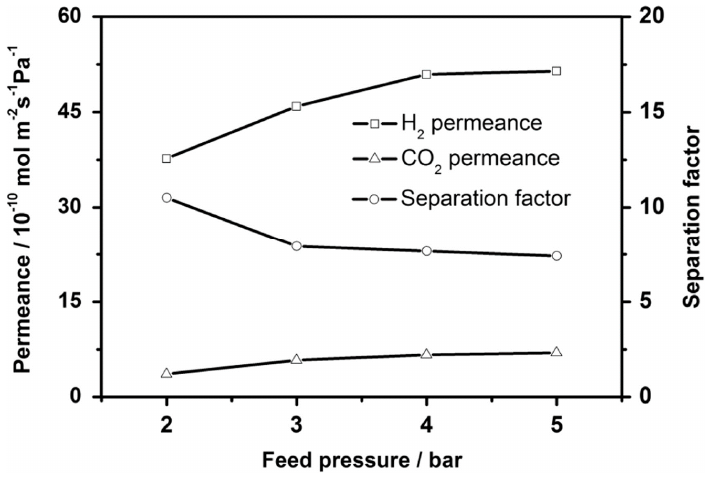
Figure 32. H 2 and CO 2 permeances from equimolar binary mixtures and H 2 /CO 2 mixed gas separation factor of the CAU-10-H membrane as a function of the feed pressure at 200 °C. (adapted with permission from ref. [132]).